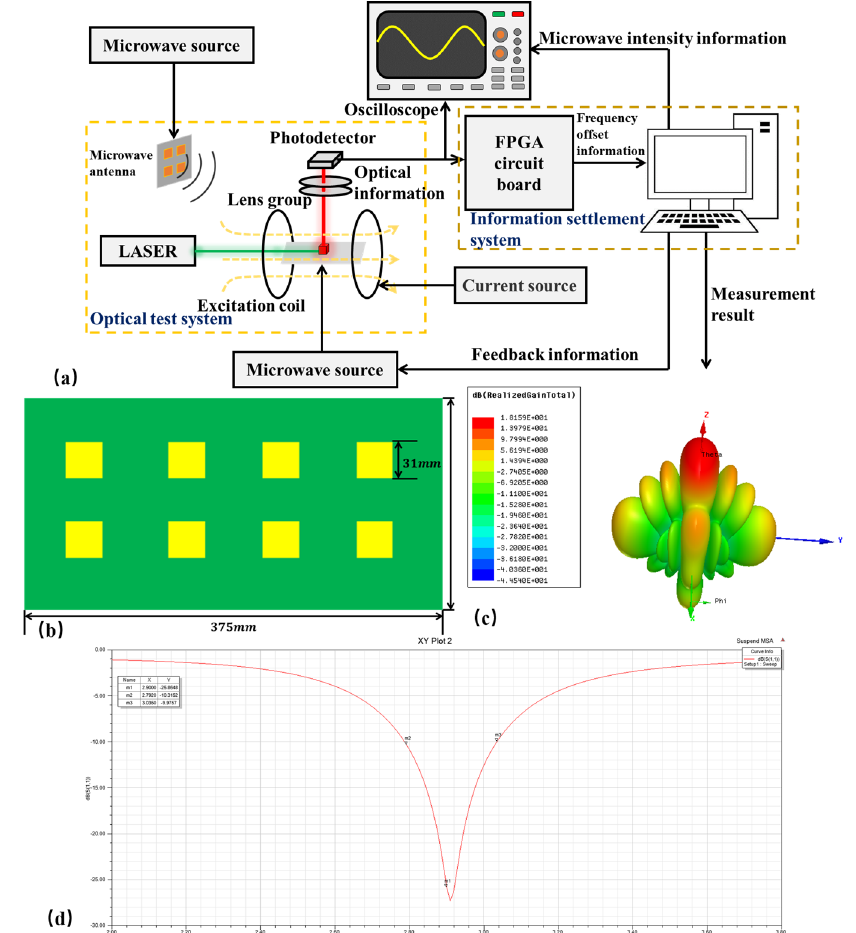
Figure 2. Schematic diagram of experimental system structure. ( a ) Schematic diagram of the overall structure of the experimental system. ( b ) Schematic diagram of array antenna structure. ( c ) Antenna radiation simulation diagram. ( d ) Simulated re fl ection coe ffi cient of microwave antenna port.